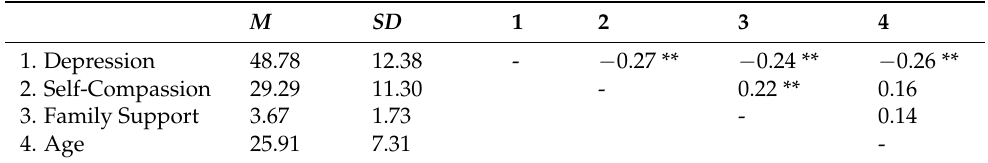
Table 2. Correlation among Study